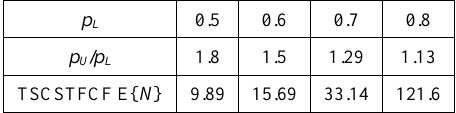
Table 10.The variation in the optimal E{ N } versus the discrimination factor